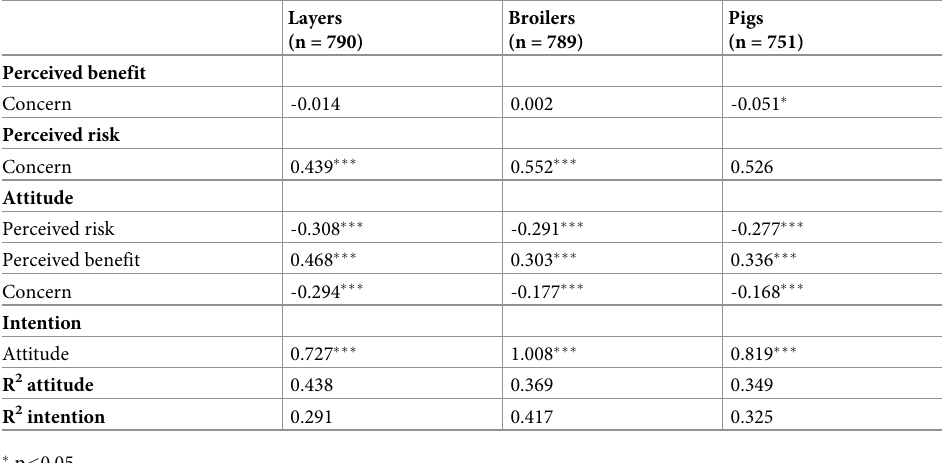
Table 10. Direct effects of the SEM model presented in Fig 1, for broilers, layer hens and